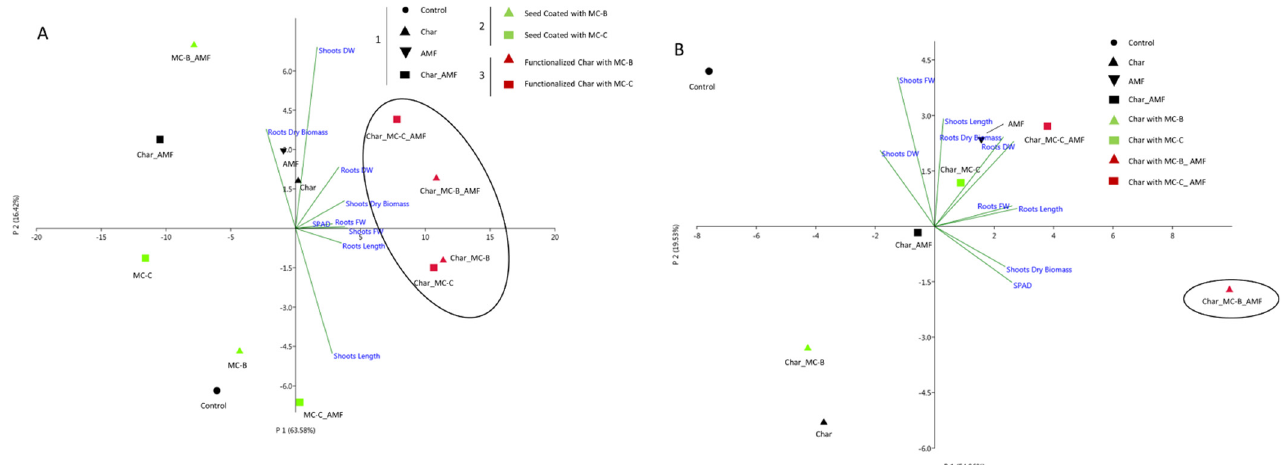
Figure 1. PCA analysis of the physiological growth data obtained for wheat ( A ) and maize ( B ) in response to different treatments. ( A ) Wheat treatments were 1 “Control” group (Control, Char, AMF, Char_AMF); 2 “Seed coating” group (MC-B, MC-C, MC-B_AMF, MC-C_AMF); 3 “Functionalized Char” group (Char_MC-B, Char_MC-C, Char_MC-B_AMF, Char_MC-C_AMF). ( B ) Maize treatments were “Control” group (Control, Char, AMF, Char_AMF); functionalized char group without AMF (Char_MC-B, Char_MC-C), and functionalized char with AMF (Char_MC-B_AMF, Char_MC-C_AMF). The colors and symbols are ordered according to the legend reported. The main groupings are indicated in circles.